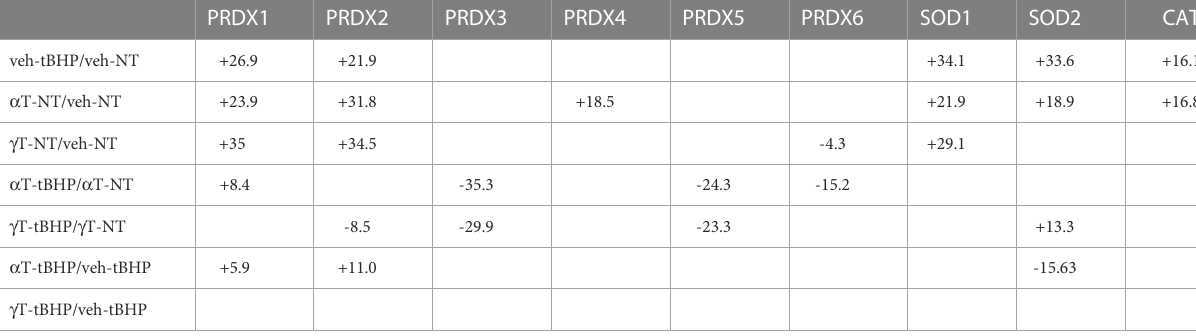
TABLE 8 The effect of tBHP, a T or g T, or a T or g T and tBHP on the expression of Peroxidases, SOD and